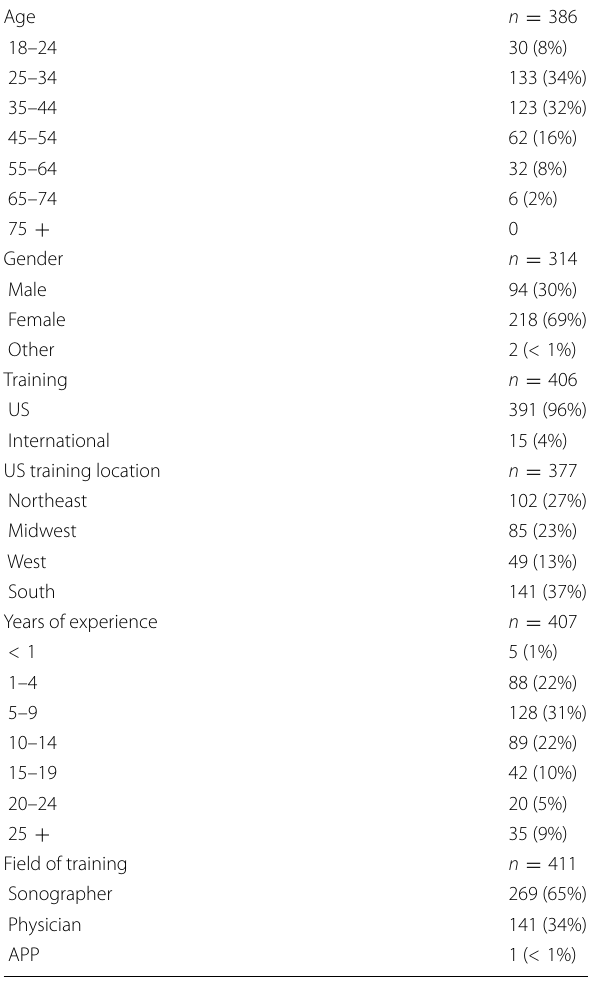
Table 2 Probe motion terminology ( n